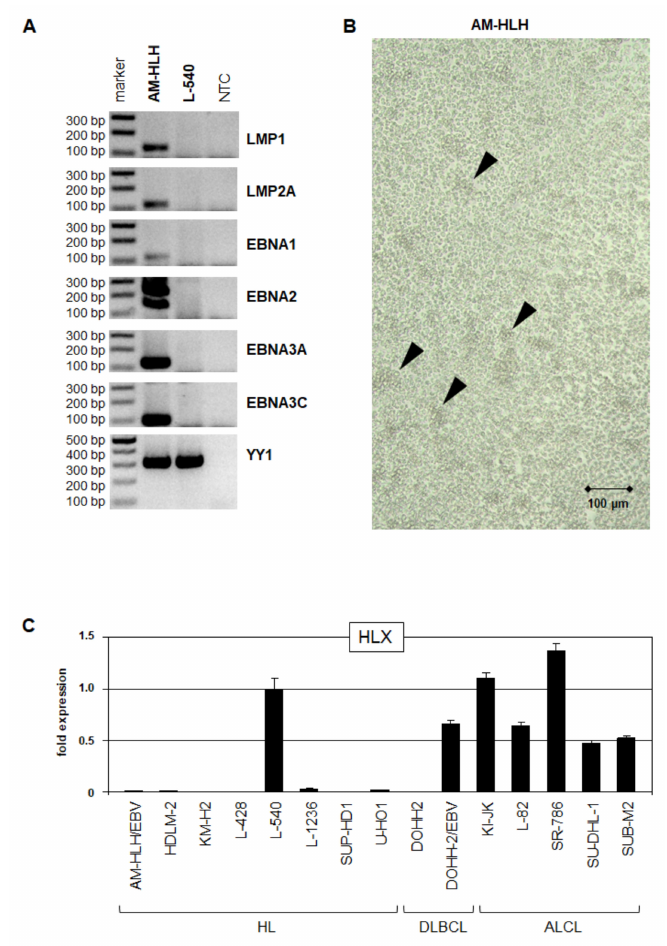
Figure 1. Expression of EBV and HLX transcripts in HL cell lines. ( A ) RT-PCR analysis of selected EBV genes in HL cell lines AM-HLH and L-540. YY1 was used as control. NTC: no template control. ( B ) Phase-contrast microscopical picture of AM-HLH cells in culture. Please note the appearance of cell aggregates which are indicative for EBV infection (arrow heads). ( C ) RQ-PCR analysis of NKL homeobox gene HLX in cell lines derived from HL, DLBCL and ALCL. Of note, we analyzed two reported DOHH-2 subclones—one was EBV-negative, the other EBV-positive. However, RQ-PCR analysis of NKL homeobox gene HLX in cell lines derived from HL, DLBCL and ALCL detected only weak expression levels in AM-HLH. This result contrasted to EBV-negative HL cell line L-540, EBV-positive DLBCL cell line DOHH-2 and all examined EBV-negative ALCL cell lines (Figure 1C). HLX is a direct target gene of STAT3, which was shown to be constitutively active in L-540, activated by EBV in DOHH-2, and amplified and activated by fusion protein NPM1-ALK in ALCL cell lines [18–20,26]. Therefore, we then focused our interest on the regulation and activity of STAT3 in